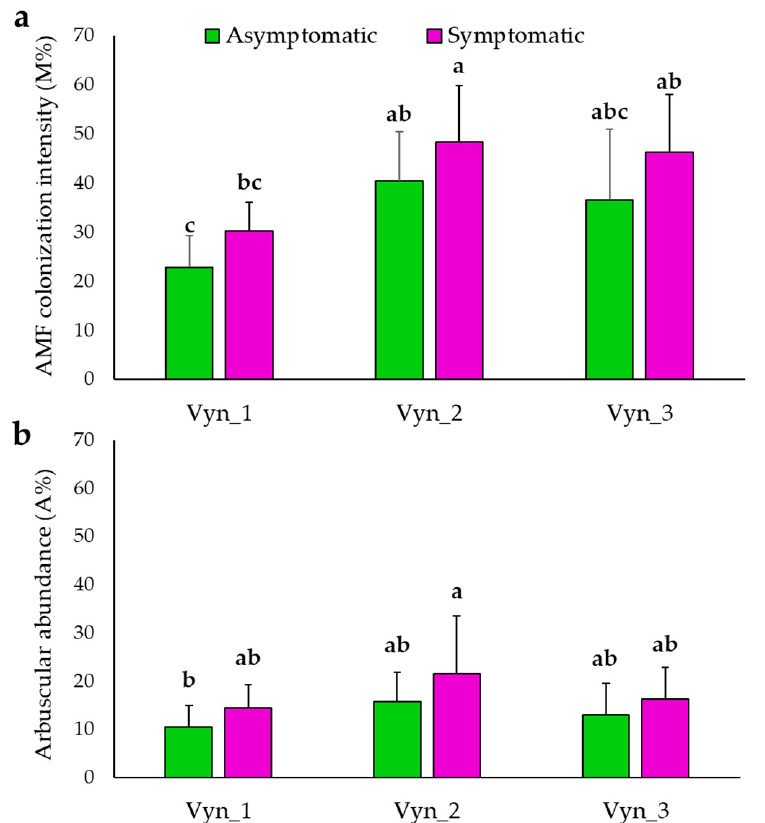
Figure 3. AMF mycelium colonization (% M) ( a ) and arbuscular abundance (% A) ( b ) detected by non-vital staining of roots of esca symptomatic and asymptomatic grapevine plants collected in three different vineyards (Vyn_1, Vyn_2 and Vyn_3). For each trait, means followed by at least one common letter are not significantly different, according to Duncan’s Multiple Range Test ( p < 0.05). The data were normalized according to the arcsine square